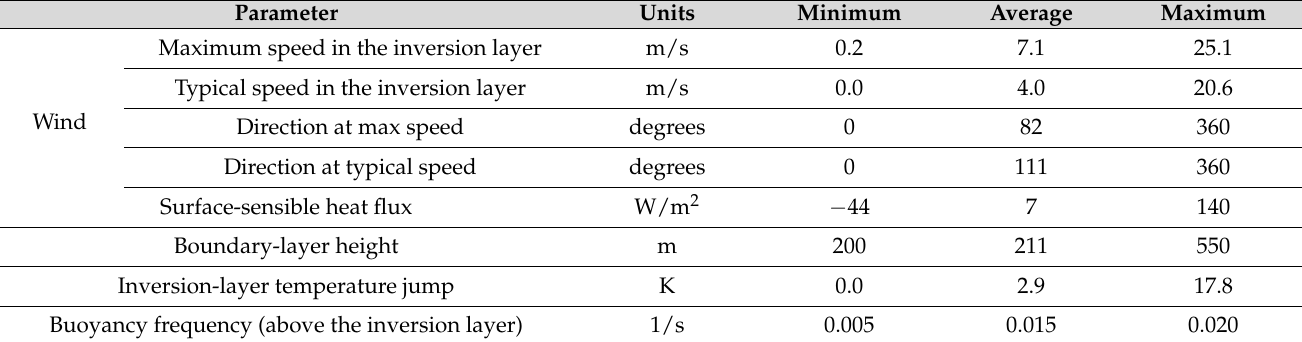
Table 5. Data summary of meteorological parameters required as input for FLOWSTAR for the period from January to April 2018.